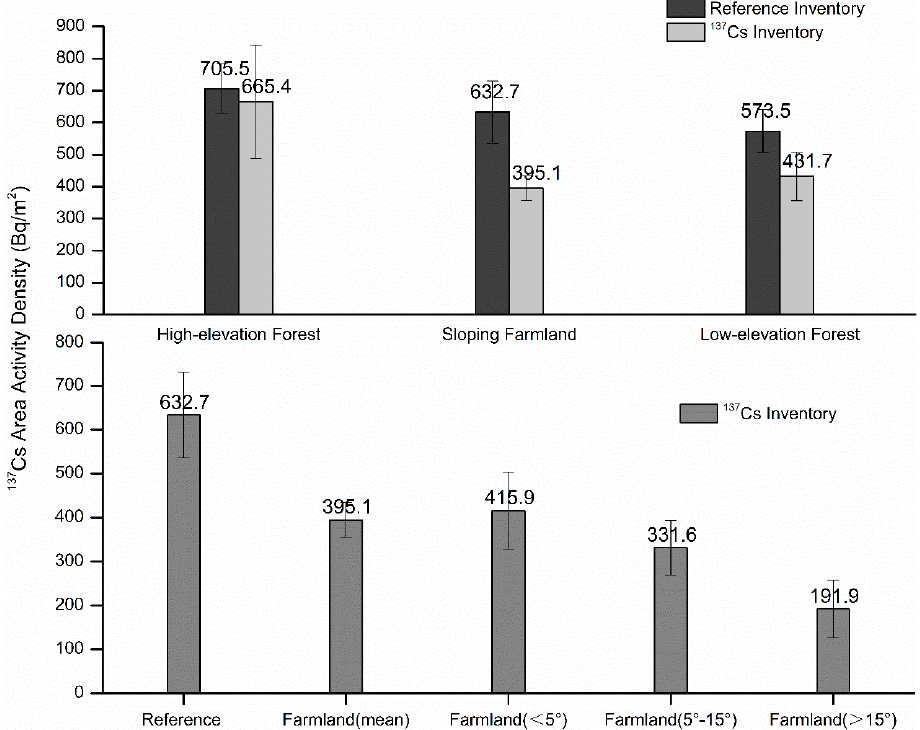
Figure 4. The variability of the reference inventory and the area activity density of 137 Cs under different land use types .